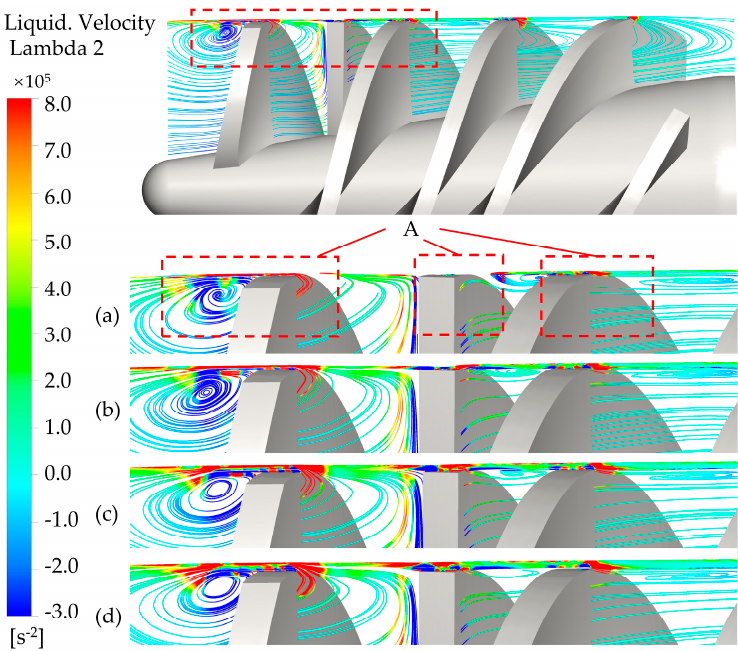
Figure 6. Tip leakage vortex (0.75 Q d ) of the shunt blade inducer with different TCs: ( a ) TC = 0.2 mm; ( b ) TC = 0.3 mm; ( c ) TC = 0.4 mm; ( d ) TC = 0.5 mm.